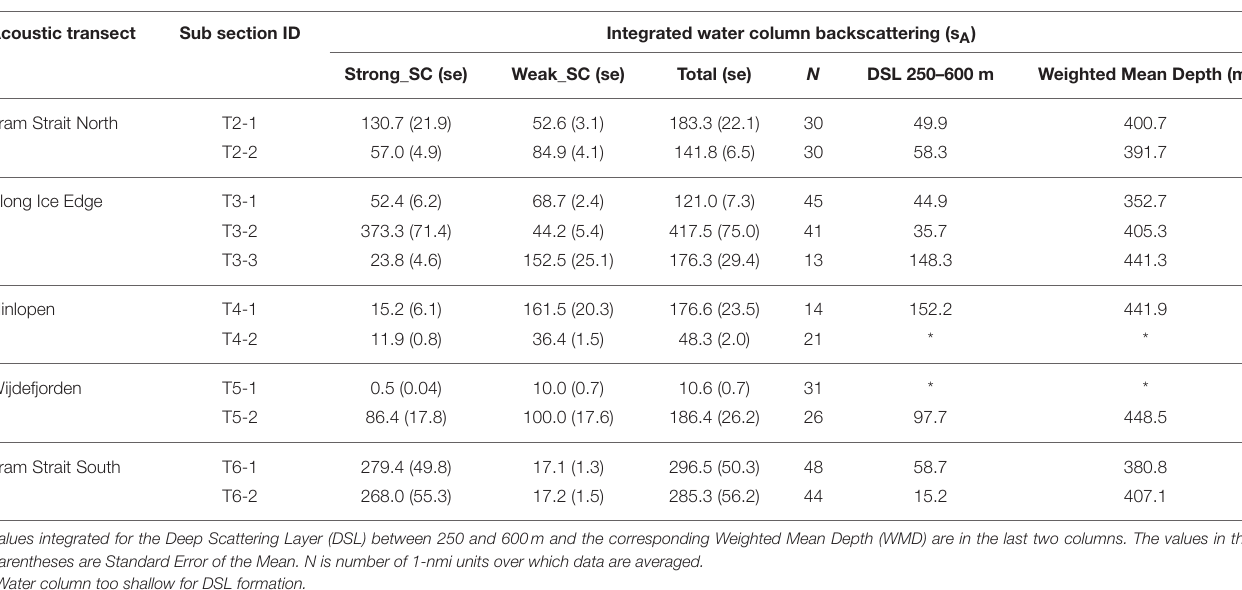
A on acoustic Transect 2 to Transect 6 (T2–T6).